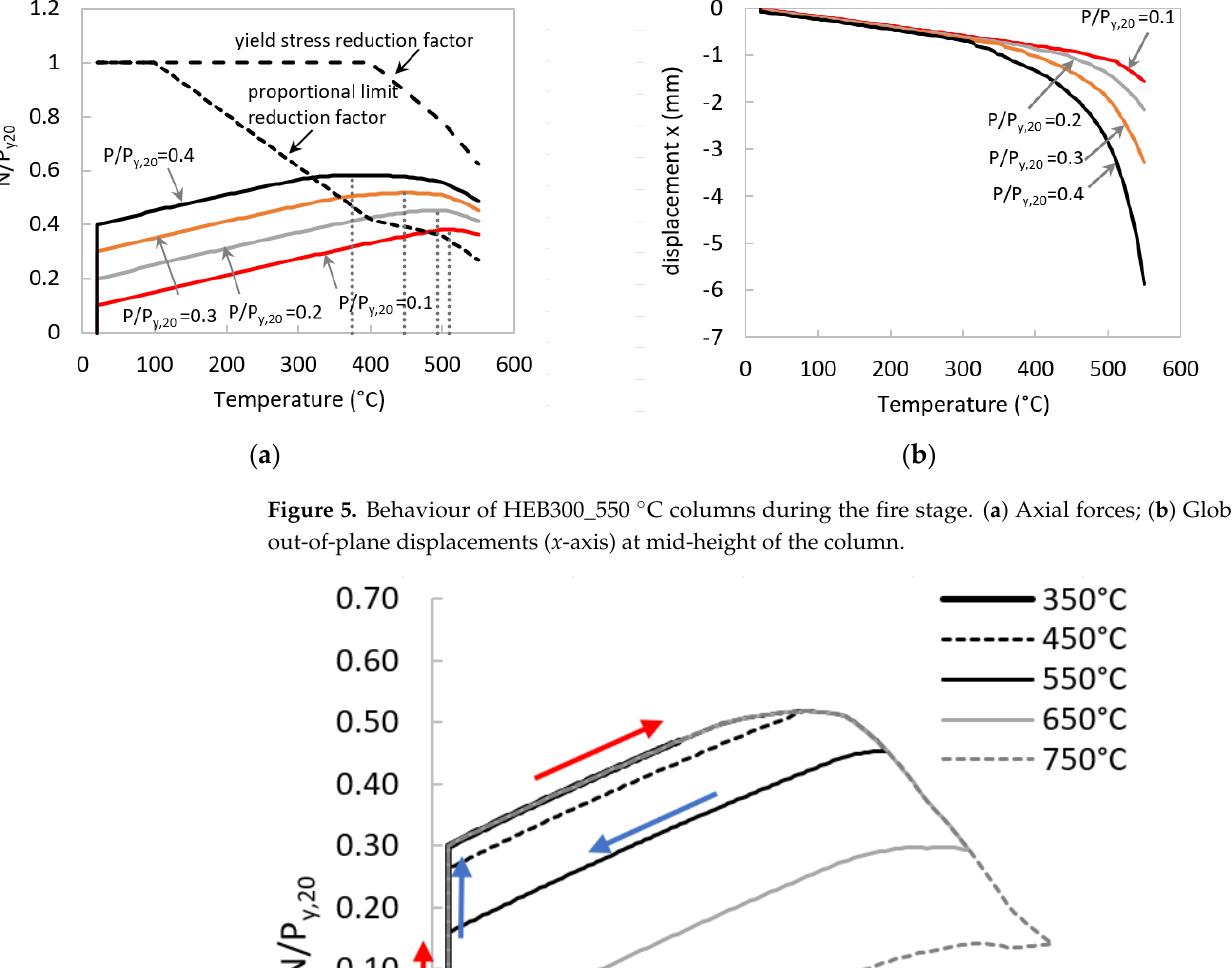
Figure 5. Behaviour of HEB300_550 °C columns during the fire stage. ( a ) Axial forces; ( b ) Global out ‐ of ‐ plane displacements (x ‐ axis) at mid ‐ height of the column.